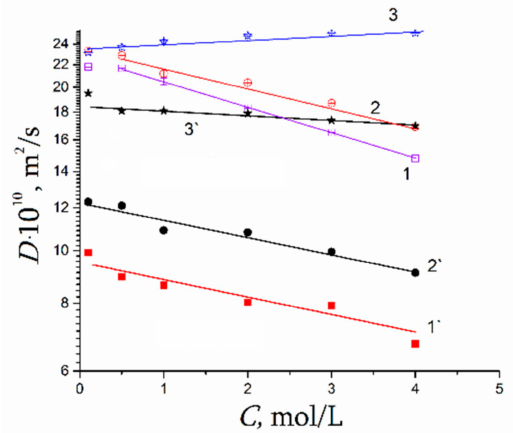
Figure 44. Water molecule and cation diffusion coefficient concentration dependences in lithium, sodium, cesium chloride aqueous solutions. (1) H 2 O in LiCl, (2) H 2 O in NaCl, (3) H 2 O in CsCl. (1 (cid:48) ) Li + in LiCl, (2 (cid:48) ) Na + in NaCl, (3 (cid:48) ) Cs + in CsCl [17].